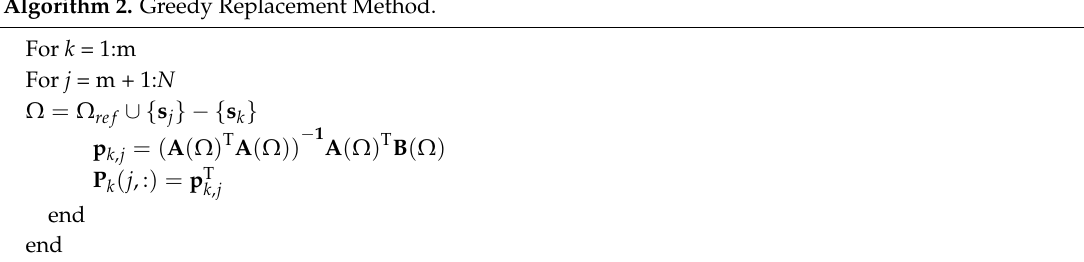
Algorithm 2. Greedy Replacement